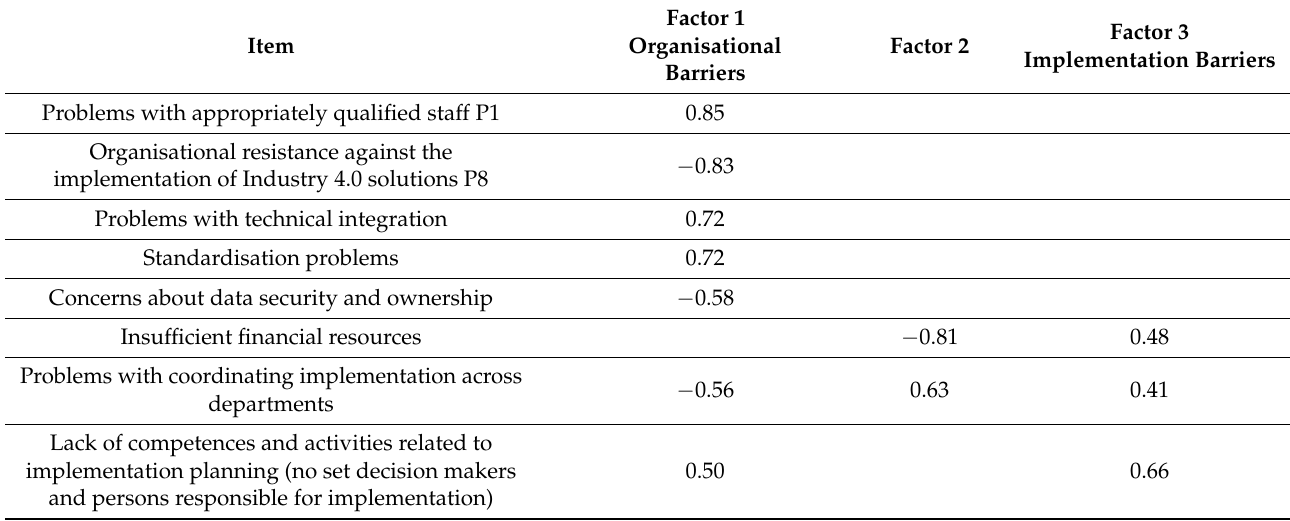
Table 7. Pattern matrix acquired in the principal component analysis regarding barriers to implementing Industry 4.0 solutions.